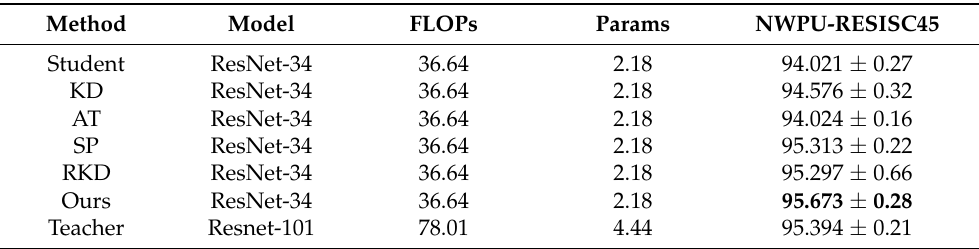
Table 3. Experiments on the NWPU-RESISC45 dataset with an 80% training ratio. ResNet-101 and ResNet-34 are adopted as the teacher model and student model, respectively. We repeat the experiments with 5 different seeds and compute the median of 5 runs as the overall accuracy (%). The standard deviation over 5 runs is reported. FLOPs means the floating point operations, in units of 10 8 FLOPs. Params means the model size (10 7 M).